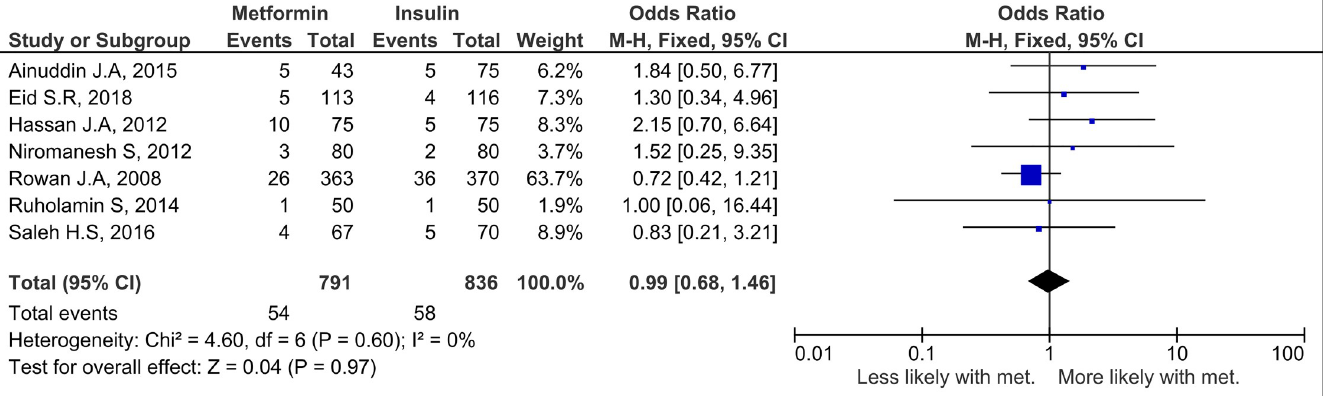
Fig 5. Small for gestational age. Expressed as OR (fixed effects model) and 95% CI. M-H, odds ratio; met., metformin.